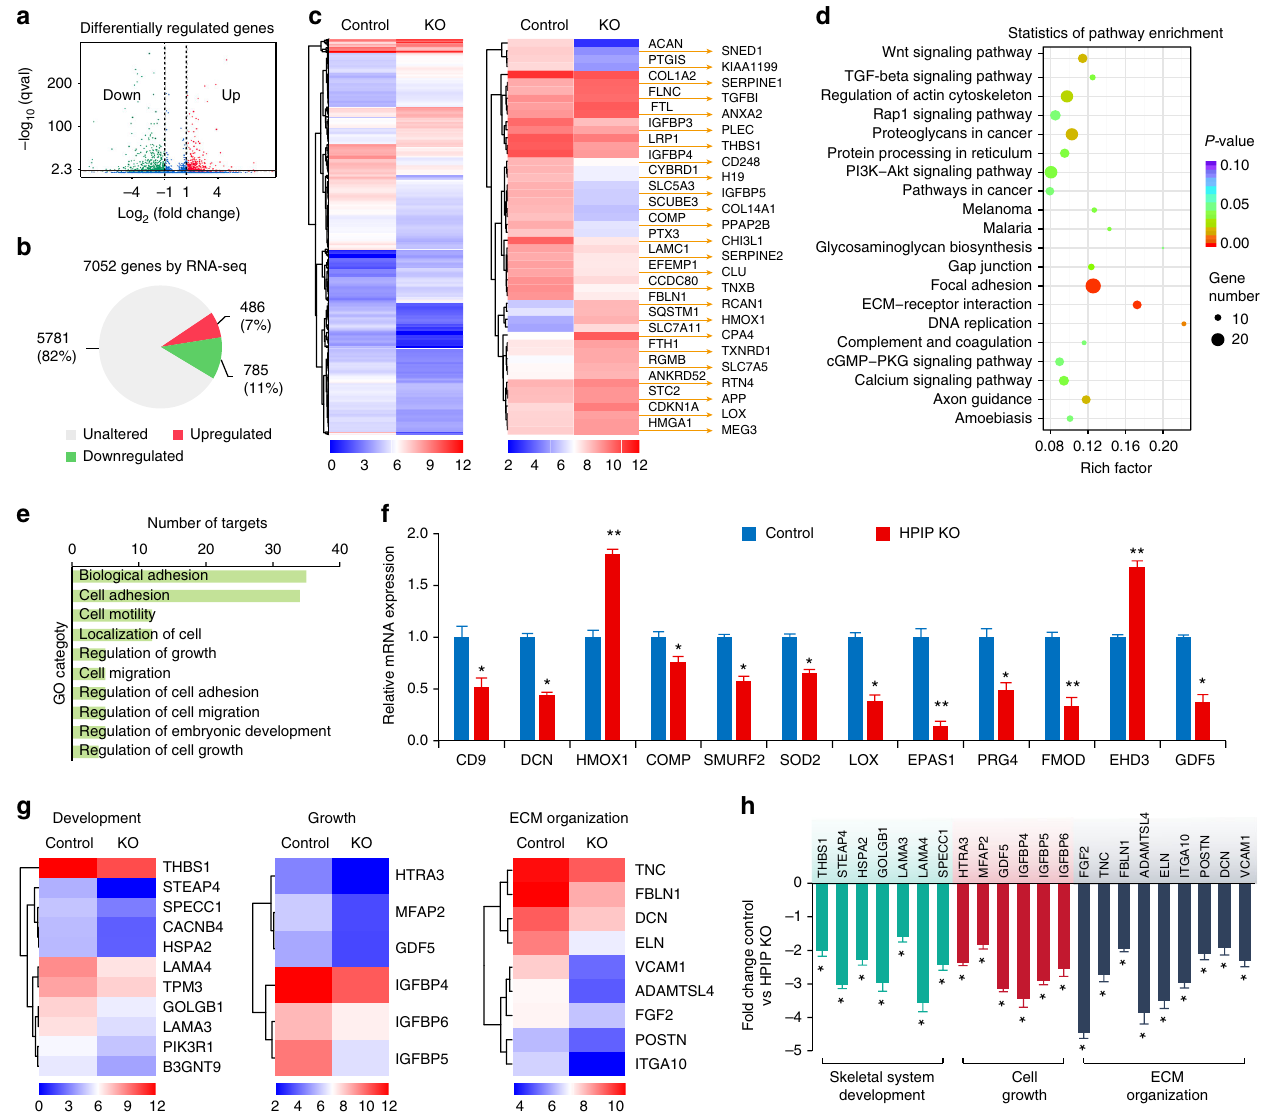
Fig. 4 RNA-seq analysis of HPIP -modulated genes. a A volcano plot illustrating differentially regulated gene expression from RNA-seq analysis between the control and HPIP knockout (KO) chondrocytes. Genes upregulated and downregulated are shown in red and green, respectively. Values are presented as the log2 of tag counts. b RNA-seq comparison revealed a total of 7052 genes expressed, of which 486 genes were upregulated and 785 genes were downregulated. c The hierarchical clustering of the RNA-seq analysis results shows all genes that were signi fi cantly different expressed (left panel) and the representative top 50 genes that were differentially expressed (right panel). d KEGG pathway analysis of downregulated targets in HPIP -de fi cient transcriptome. e gene ontology (GO) functional clustering of genes that were downregulated for biological processes. (The top 10 most signi fi cantly affected categories are shown). f qRT-PCR validation analysis of the indicated genes regulated by HPIP . g Heatmap of representative cartilage development, growth, and extracellular matrix (ECM) organization-related genes. h qRT-PCR validation analysis shows the mRNA expression fold change of skeletal system development, cell growth and ECM organization-associated genes in the control vs HPIP KO chondrocytes. Error bar represents the standard deviation (s.d.) and P- value was generated by using one-way ANOVA with Tukey ’ s post hoc test. * P < 0.05; ** P <